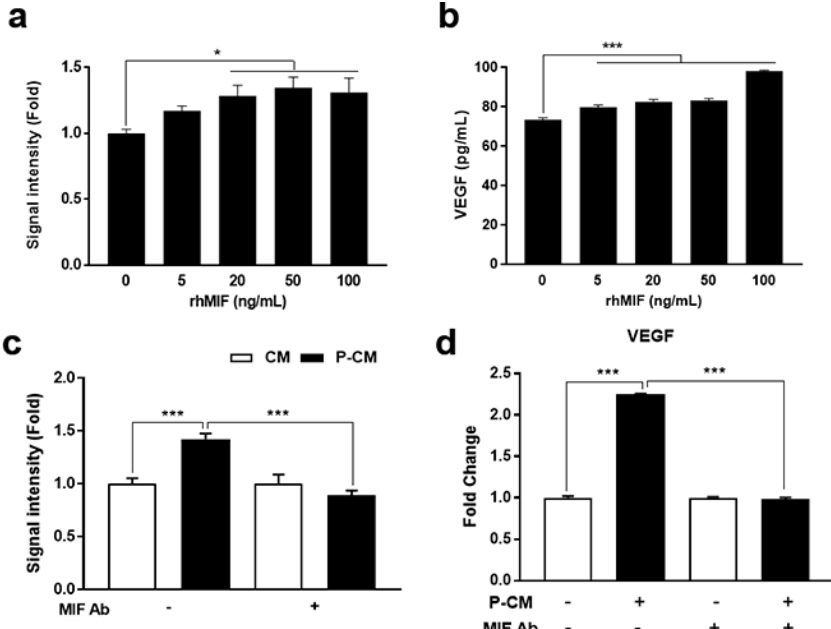
Figure 4. Increased levels of MIF in MSCs, following priming, increased the cell viability by regulating the secretion of VEGF in DPCs. ( a ) The cell viability of DPCs, measured by CCK-8, demonstrated an increased viability in the presence of recombinant human MIF proteins. ( b ) The supernatants of DPCs were collected to analyze the secretion of VEGF after treatment with varying concentrations of MIF proteins. ( c ) To confirm the e ff ect of MIF on the viability of DPCs, MIF-neutralizing antibodies were added with CM or P-CM. The cell viability of DPCs was reduced following MIF neutralizing antibody exposure. ( d ) The increased VEGF levels following the P-CM treatment of DPCs was significantly impaired following the addition of the MIF neutralizing antibodies. Data represent the mean ± SD. Each experiment was repeated at least three times. Statistically significant di ff erences were determined by one-way nonparametric ANOVA. * p < 0.05 and *** p < 0.001. Abbreviations: MIF, macrophage migration inhibitory factor; CM, MSC-derived conditioned medium; P-CM, primed MSC-derived conditioned medium; VEGF, vascular endothelial growth factor; MIF, macrophage migration inhibitory factor.